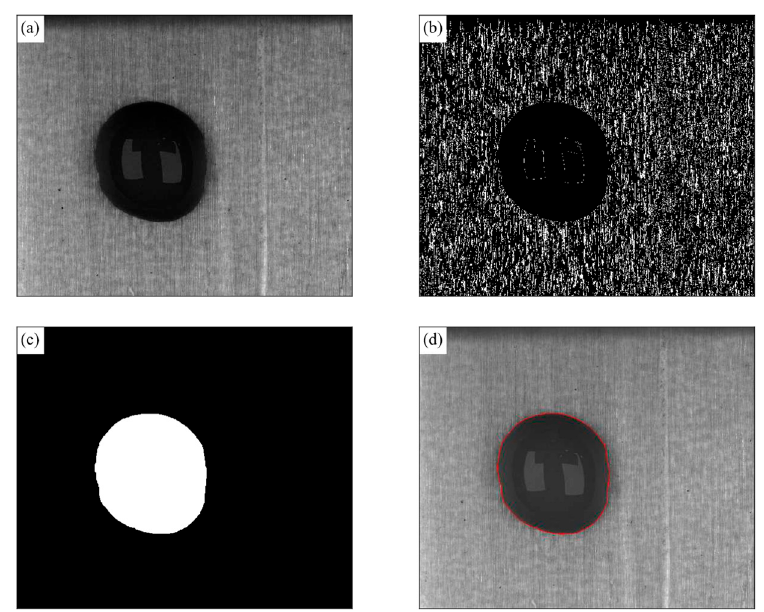
Figure 8. Droplet image processing using the thresholding method at various steps: ( a ) grayscale, ( b ) Canny detection, ( c ) filtered, and ( d ) boundary traced.